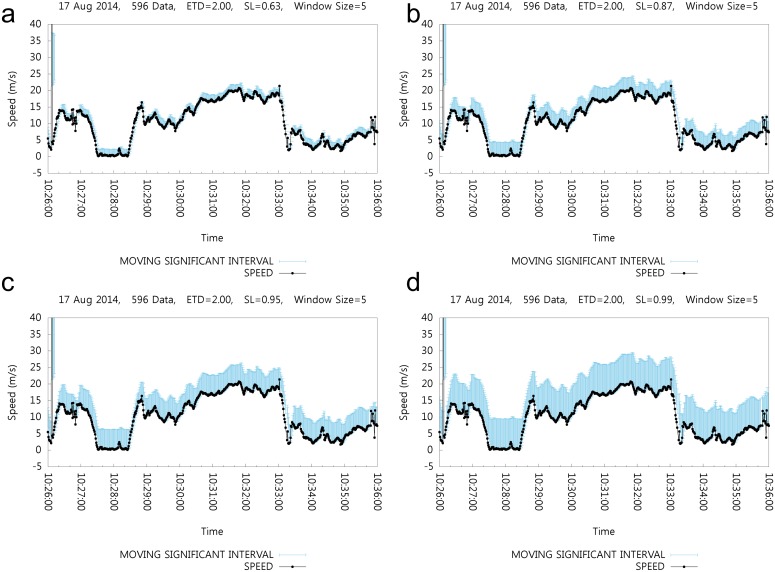
Effect of the Significant Level.